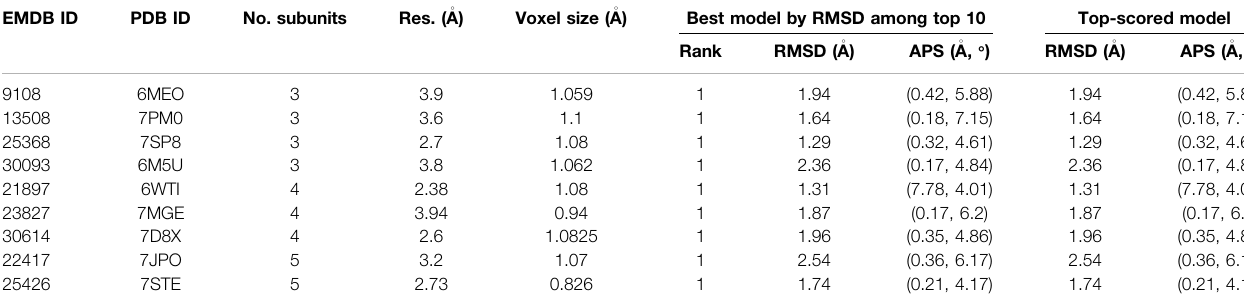
TABLE 2 | Modeling accuracy in the high-resolution experimental map dataset. EMDB ID PDB ID